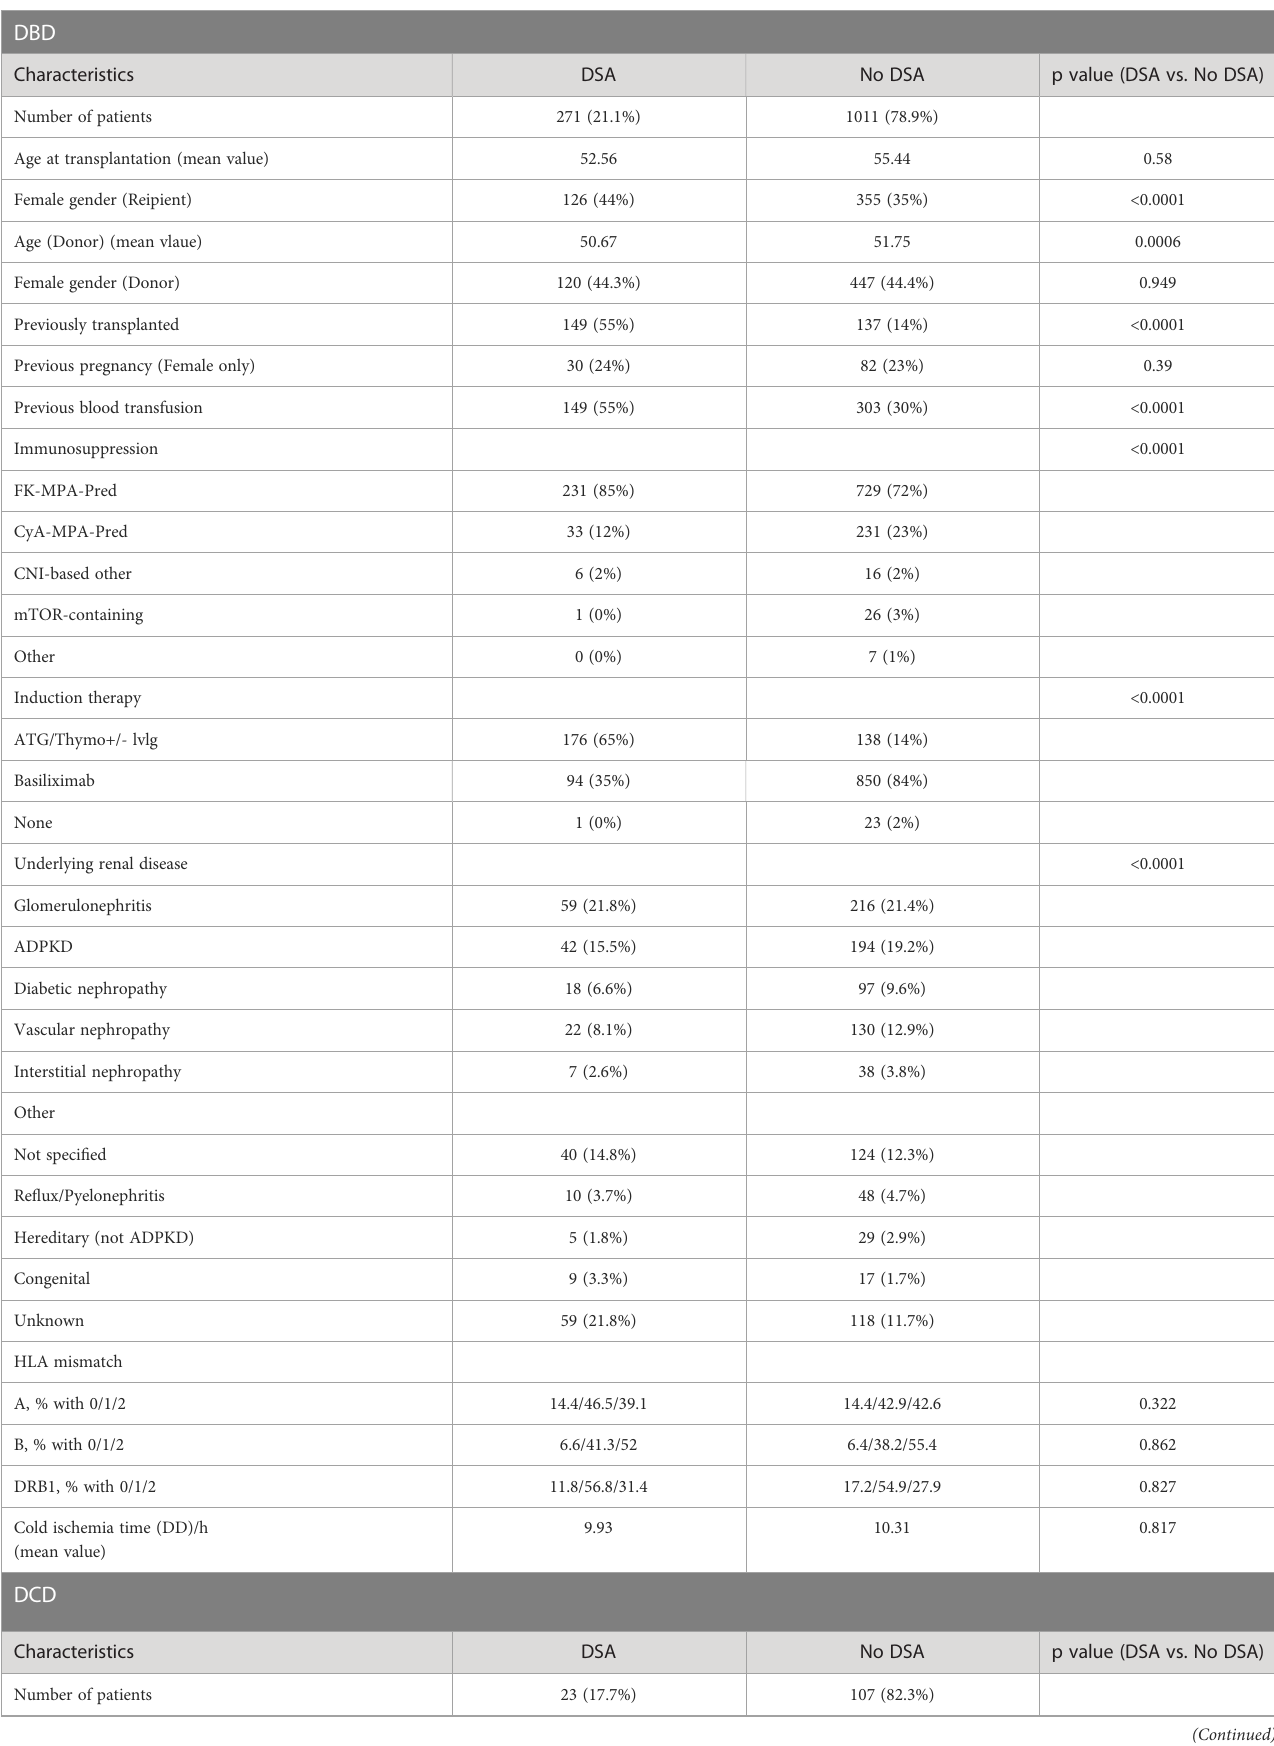
TABLE 1 Characteristics of the recipient transplanted with kidney from different donor types with and without pre-transplant